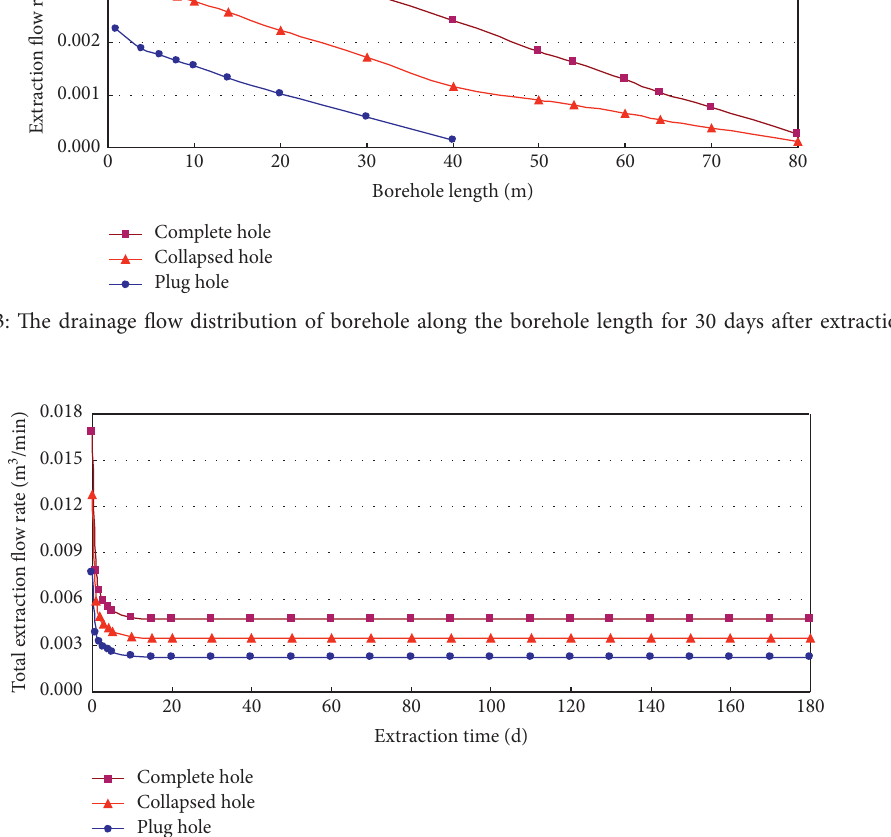
Figure 14: The total flow change of complete hole, collapsed hole, and plug